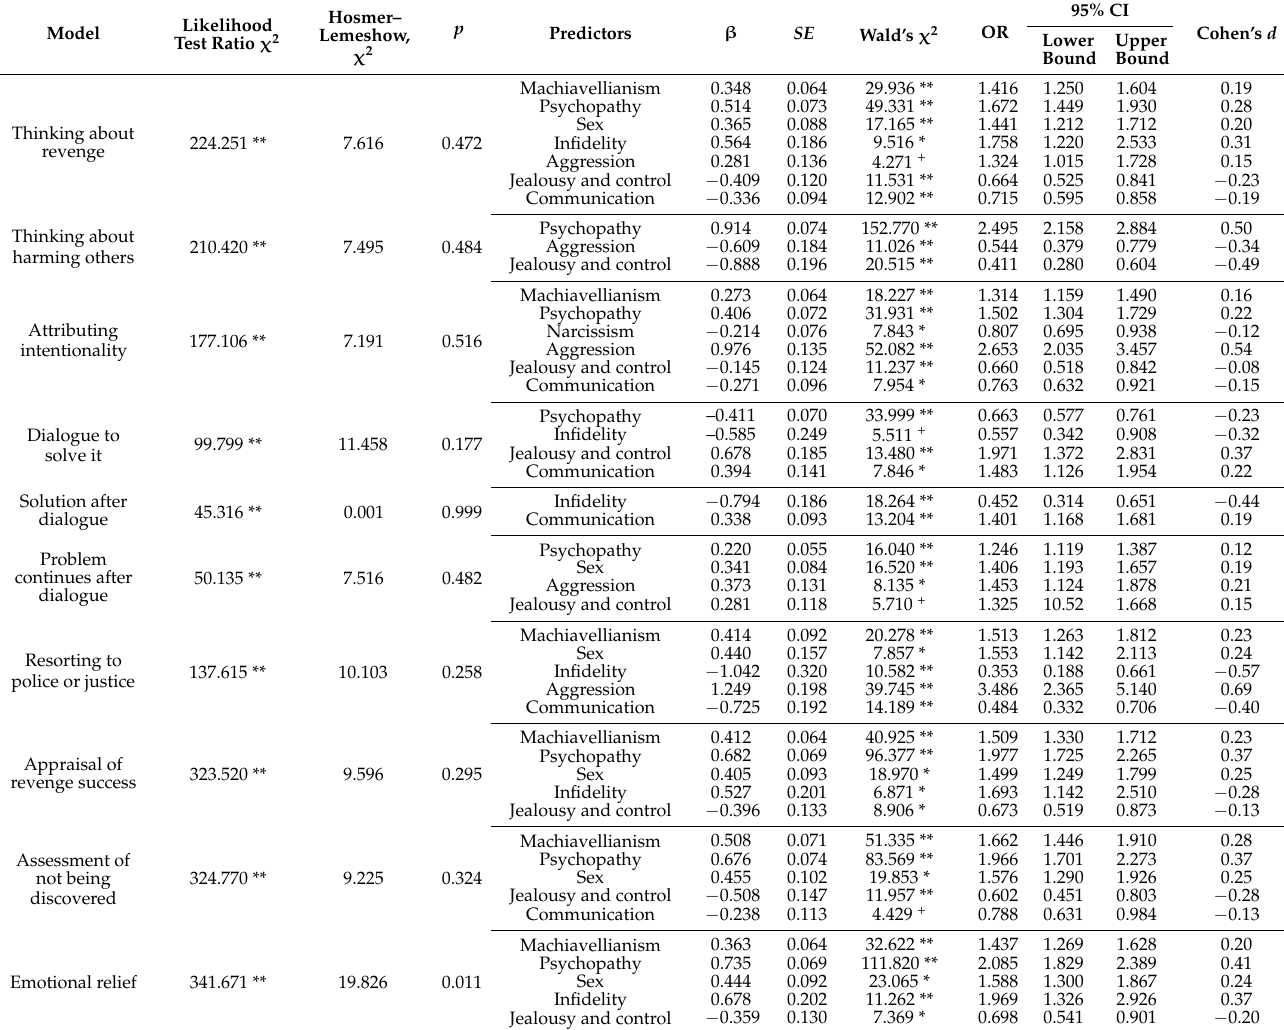
Table 3. Logistic regression models for thoughts and behaviors related to